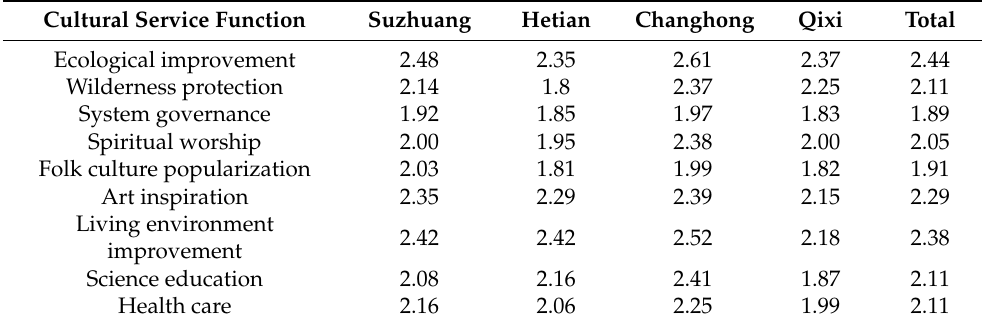
Table 4. Community residents’ cognitive scores of cultural service functions. Cultural Service Function Suzhuang Hetian Changhong Qixi Total Ecological